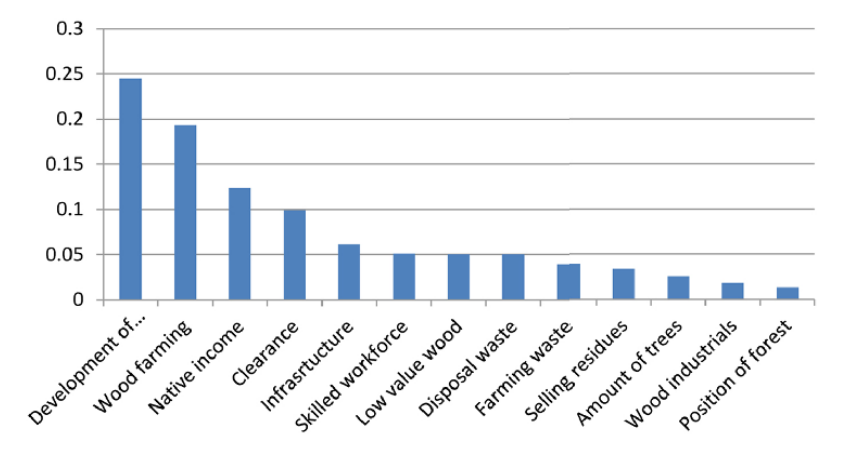
Figure 7: Final synthesis of benefits indices (inconsistency rate 0.03), X: Criteria, Y: Weighing